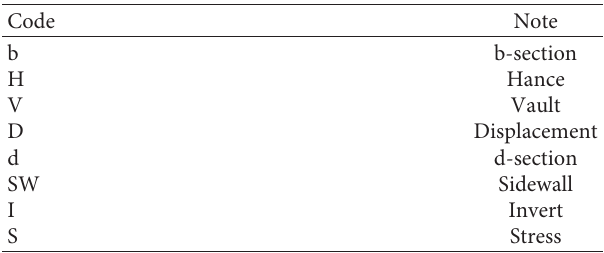
Figure 10: Displacement curves of a multipoint displacement meter. Table 6: Measuring point codes.